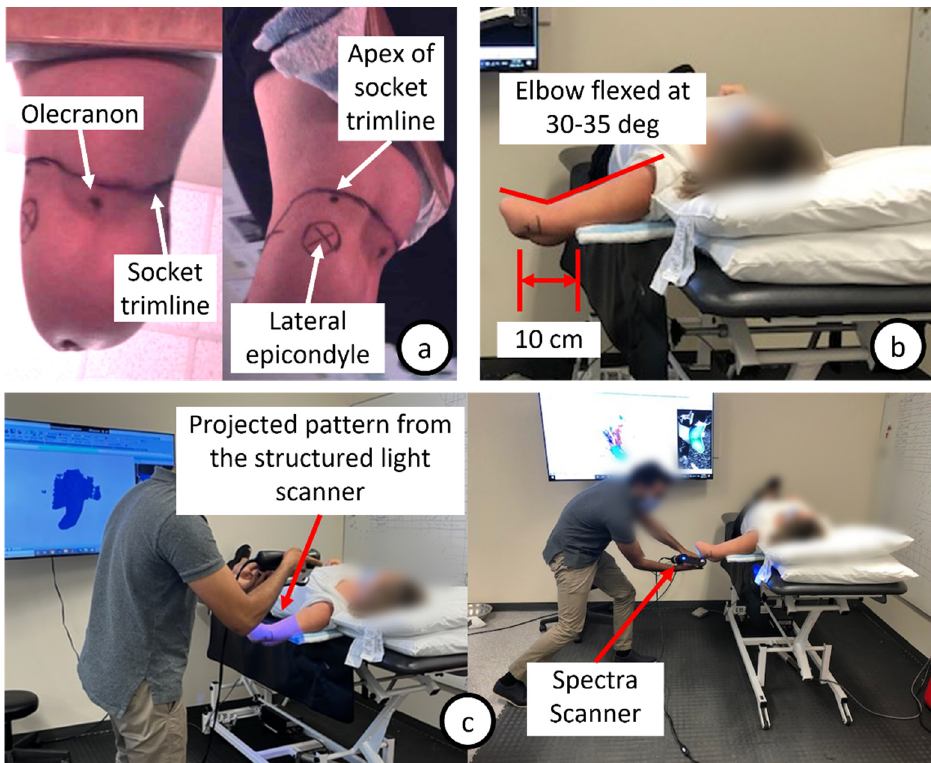
Figure 2. ( a ) Key anatomical landmarks identified and marked by the treating prosthetist; ( b ) The limb absentee is instructed to lay supine on a height-adjustable bed with their residual limb shoul- der placed onto a thin wooden board; ( c ) The scanner is aimed at the residual limb directly above its surface., then moved in a steady and continuous manner either clockwise or counterclockwise around the residual